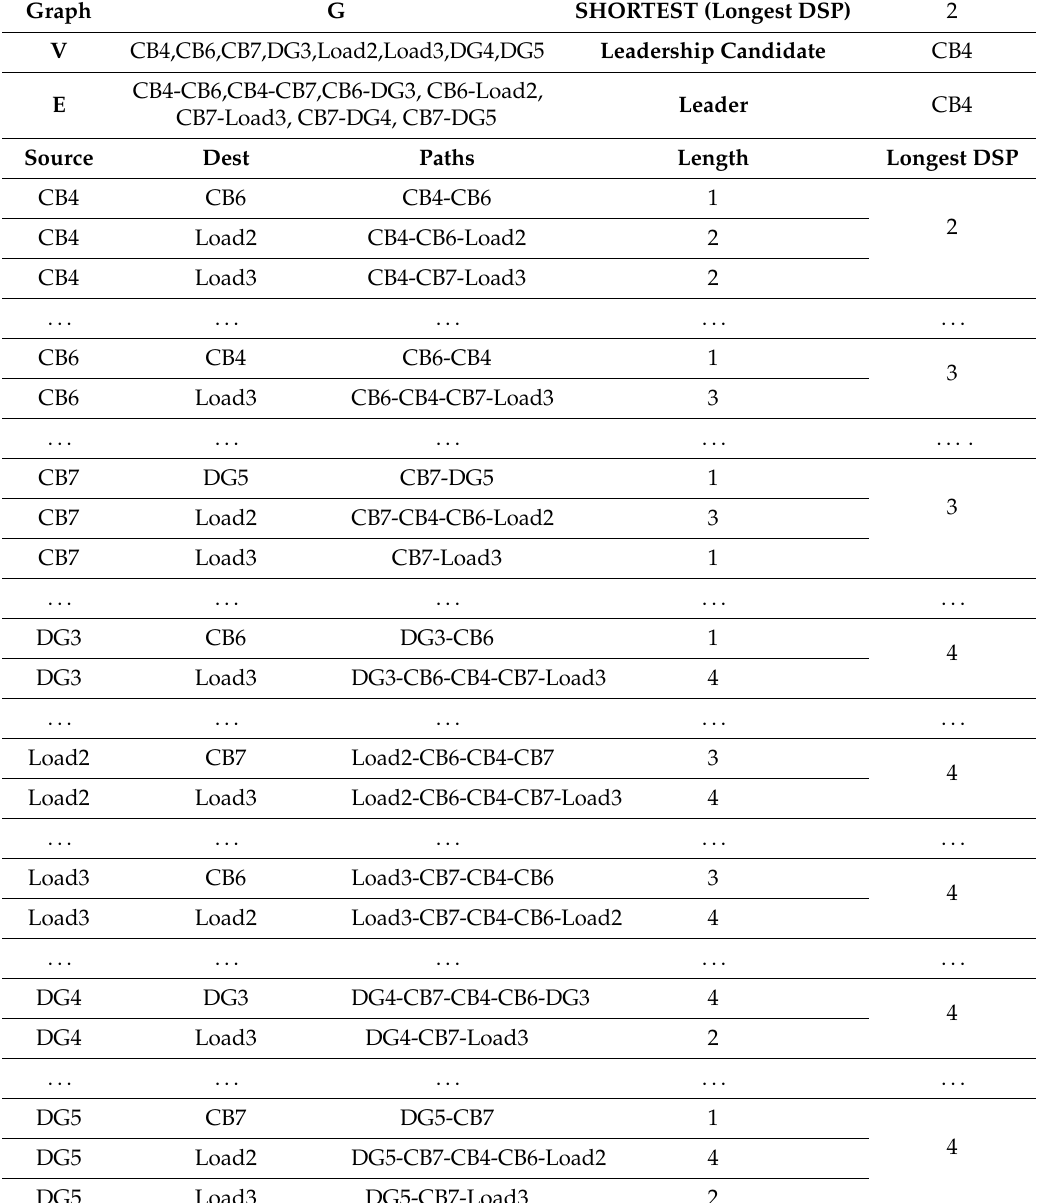
Table 5. Leader election algorithm in network